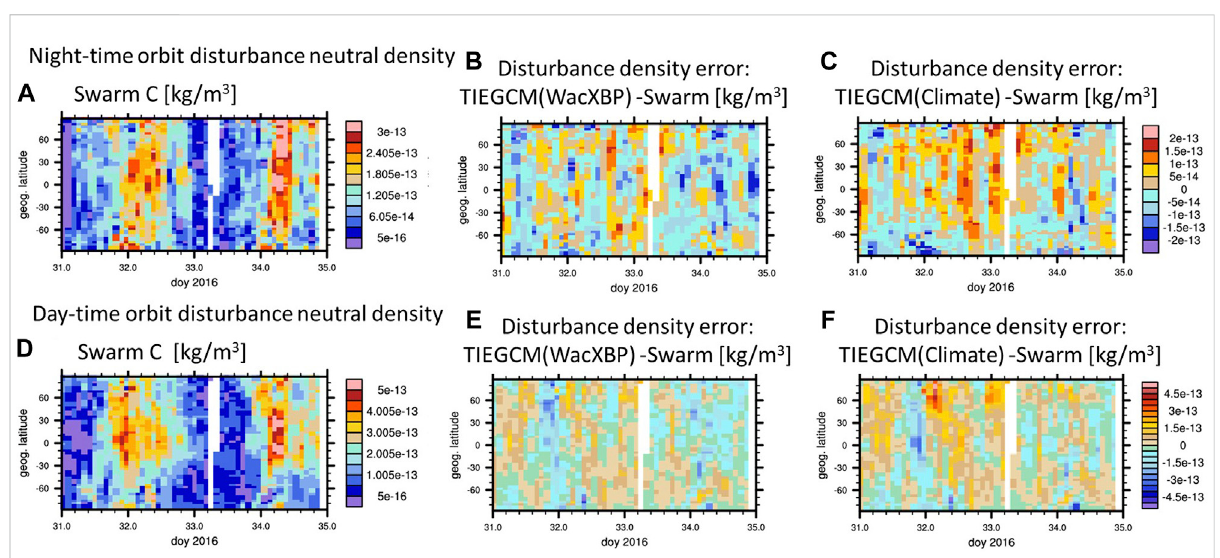
FIGURE 12 Disturbanceneutraldensityvariationbyremovingaverageofdoy30UT0 – 21fornight-timeorbit[panel (A – C) ]andday-timeorbit (D) and (F) of Swarm C disturbance neutral density (A) and (D) and difference of disturbance variations between TIEGCM(WacXBP) and Swarm-C (B) and (E) and between TIEGCM(Climate) and Swarm-C (C) and (F)